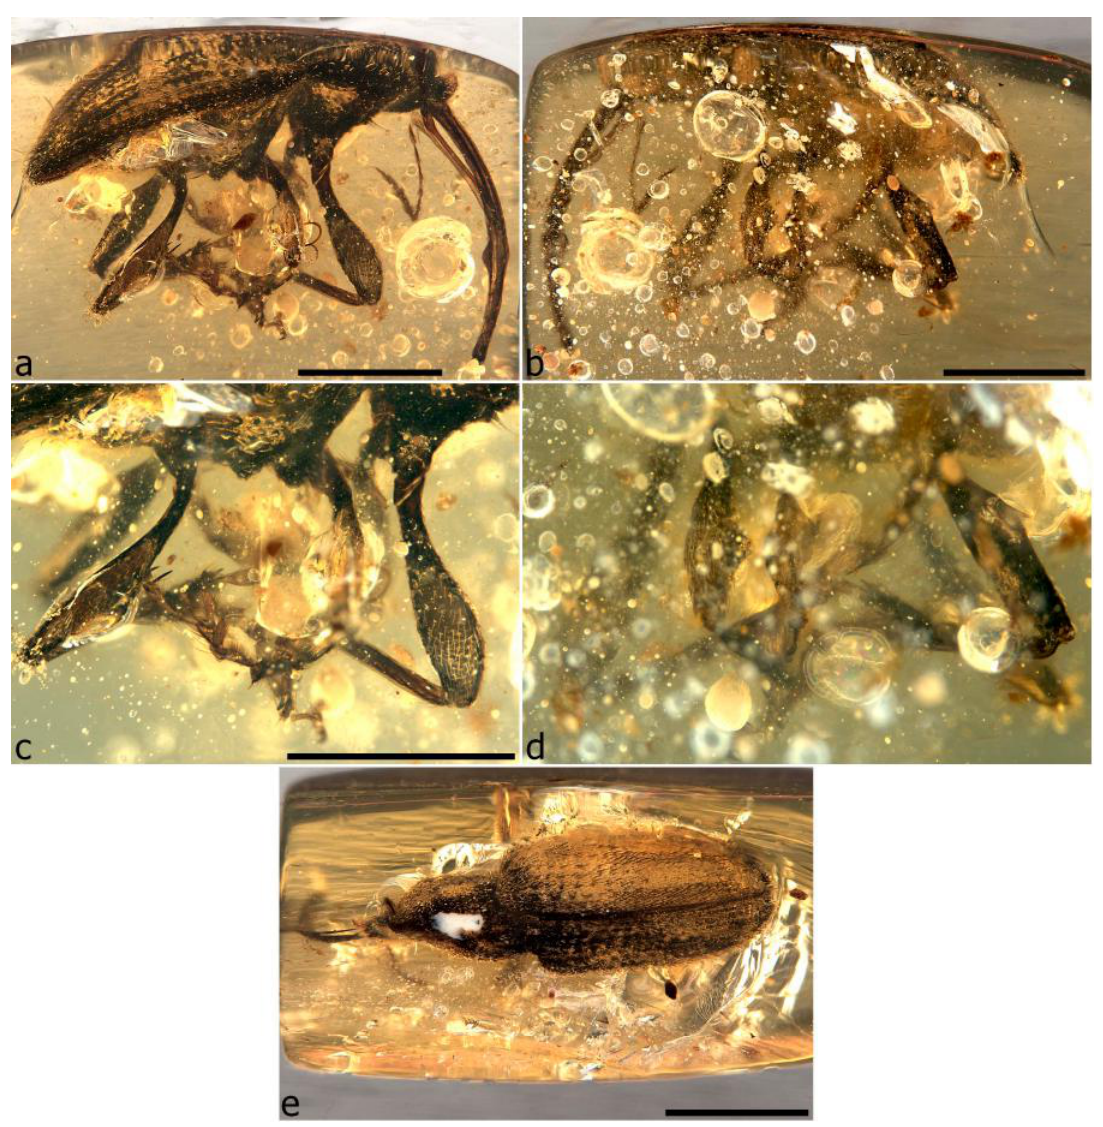
Figure 62. Mekorhamphus tenuicornis sp. n., holotype. Habitus, right lateral ( a ); habitus, left lateral ( b ); legs, right lateral ( c ); legs, left lateral ( d ); habitus, dorsal ( e ). Scale bars: 1.0 mm (a–c,e). Material examined. Holotype (NIGP156995): reasonably well-preserved specimen, slightly distorted in dorsal view, with legs and rostrum compressed, pronotum dorsally slightly cut into; in middle but close to dorsal surface of rectangular cuboid 4.3 × 3.0 × 2.0 mm; amber clear but with many subparallel vertical flow lines on right and vertical layer of dense bubbles and impurities of varying sizes on left side of specimen, largely obscuring it.